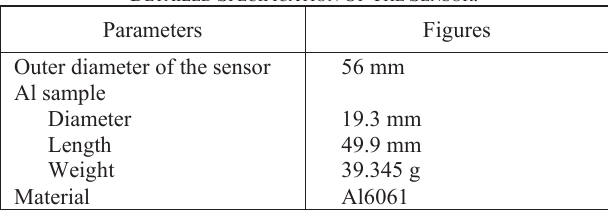
TABLE 1 D ETAILED S PECIFICATION O F T HE S ENSOR .